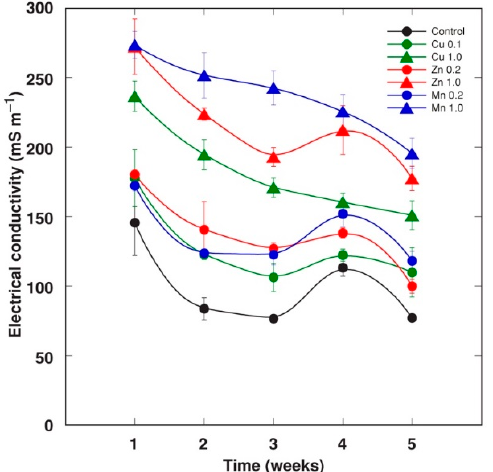
Figure 1. Effect of treatment with different concentrations of Cu, Zn, and Mn on changes in substrate electrical conductivity in containers with H. maximum (Experiment 1). Data are means ± SE from 5 replicates, each with 4 measurements, for each point.